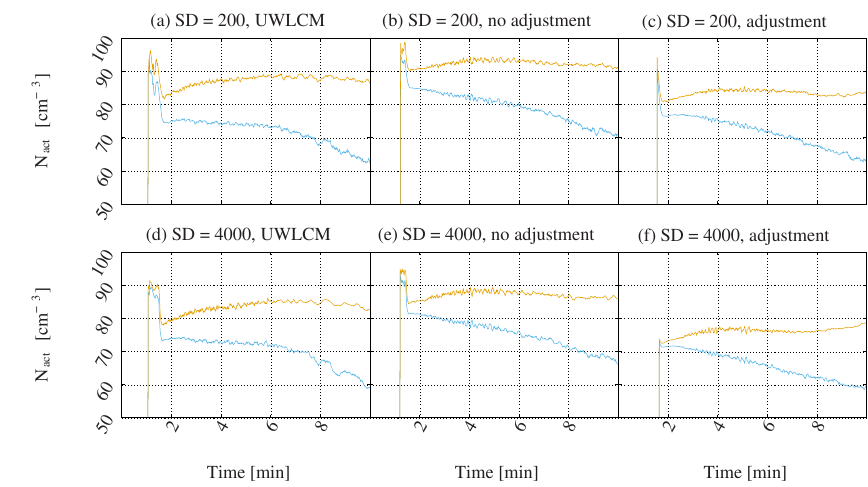
Figure 8. As in Fig. 7, but for the droplet concentration N act .